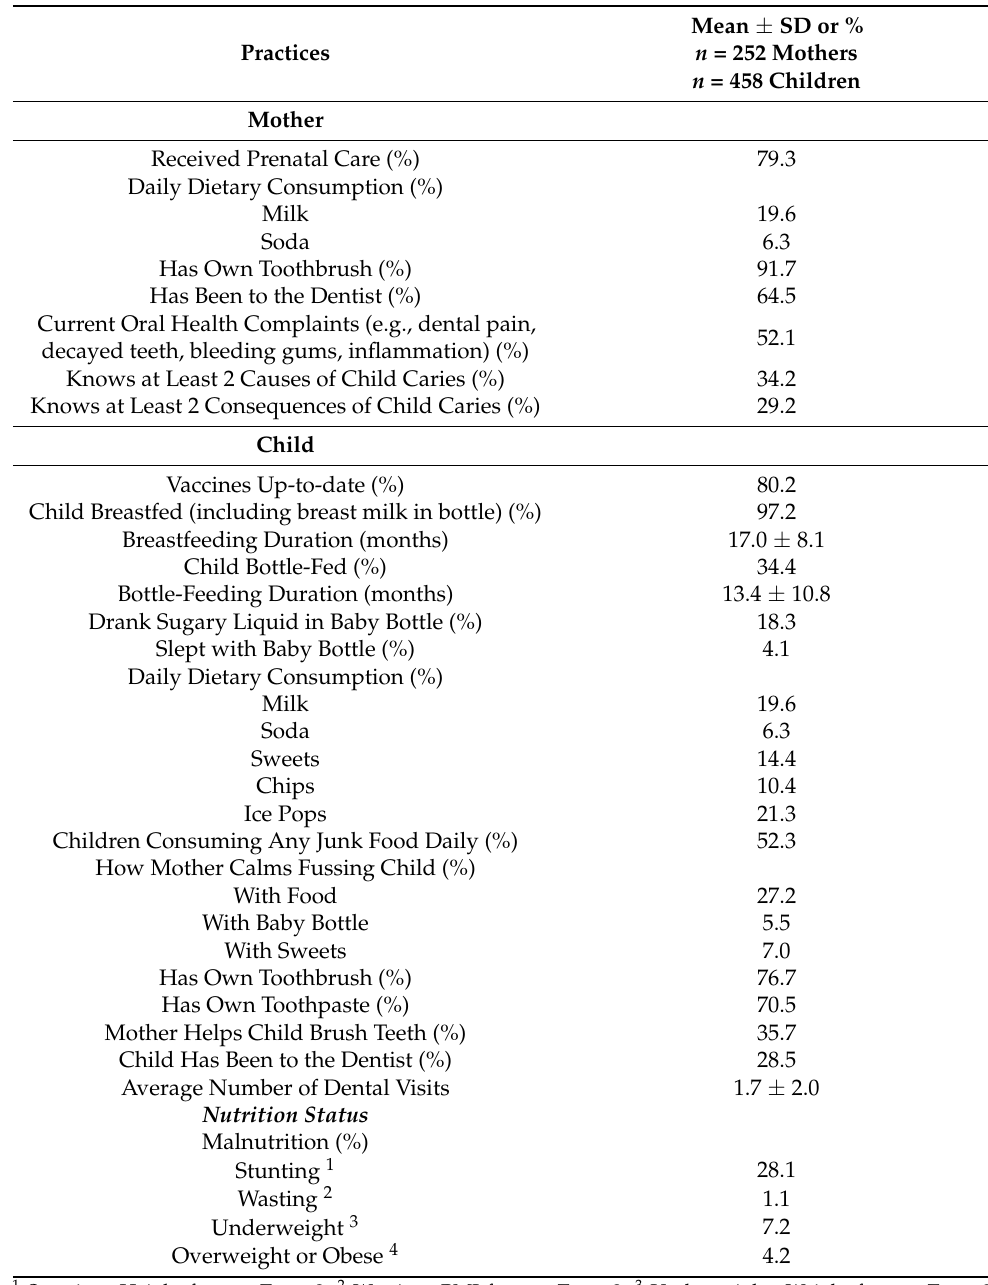
Table 2. Maternal-Child Oral Health Practices, and